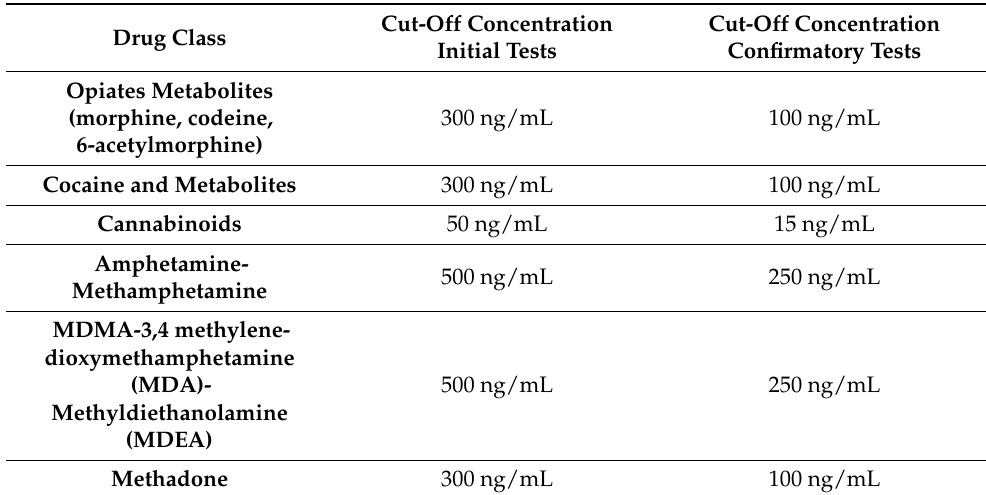
Table 2. Threshold concentration (cut-off) in the initial tests and in the confirmatory tests for positivity rates of drug classes in urine (based on the State-Regions Agreement No. 178 of 18 September